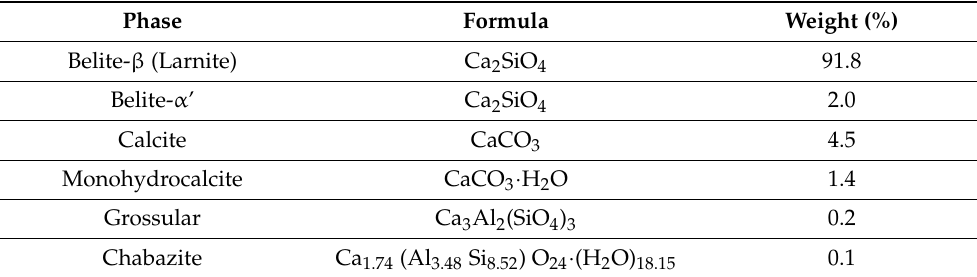
Table 2. Identification of the OS crystalline phases and estimation of their quantitative